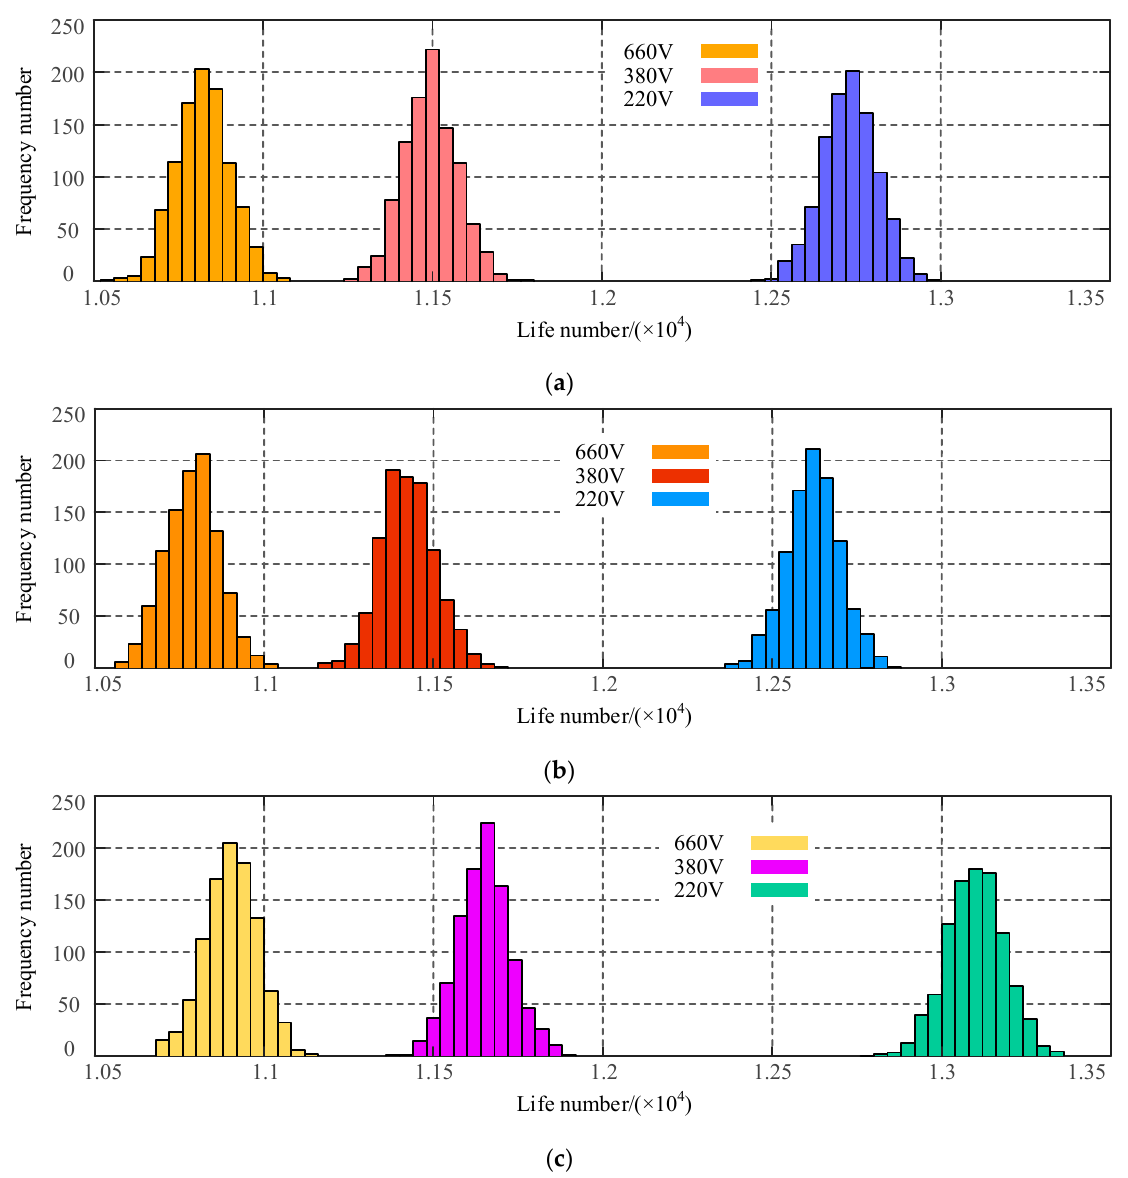
Figure 11. Histogram of electrical life distribution. ( a ) Electrical life distribution under different supply voltages when power factor is 0.35; ( b ) electrical life distribution under different supply voltages when power factor is 0.65; ( c ) electrical life distribution under different supply voltages when power factor is 0.95.